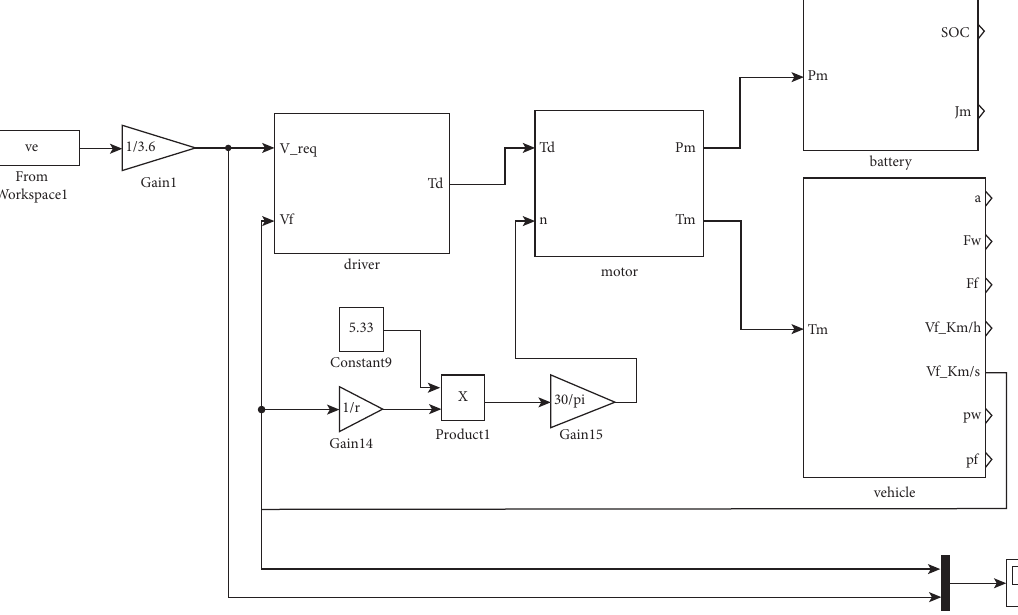
Figure 4: EV simulation